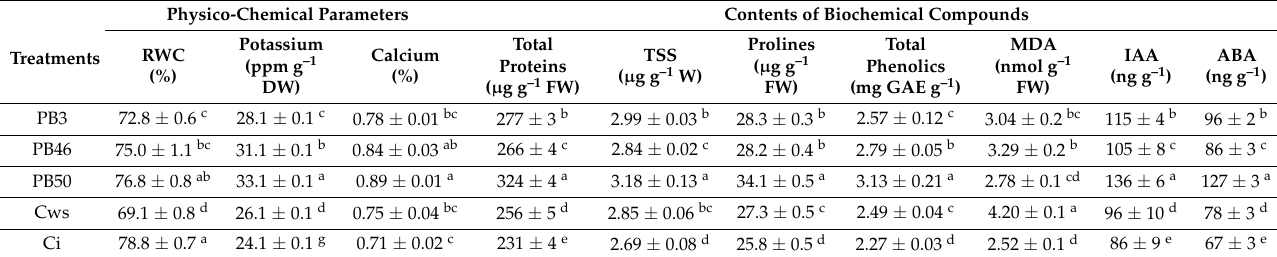
Table 1. Means and ± SD (n = 4) of the physicochemical parameters (RWC (relative water content), potassium, and calcium content) and contents of biochemical compounds (total proteins, total soluble sugars (TSS), total phenolics, prolines, malondialdehyde (MDA), indole acetic acid (IAA), and abscisic acid (ABA)), in the rice leaves of different treatments after 10 days of drought stress. PB3, drought stress with B. endophyticus PB3 foliar spray; PB46, drought stress with B. altitudinis PB46 foliar spray; PB50, drought stress with B. megaterium PB50 foliar spray; Cws, drought stress control and Ci, irrigated control; FW, fresh weight; GAE, gallic acid equivalent; DW, dry weight. Parameter values with different letters are significantly different according to Duncan’s test, p <